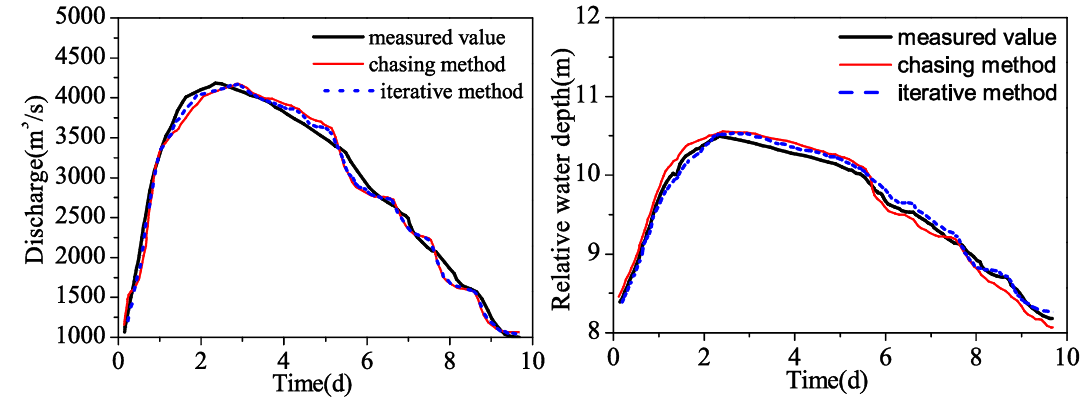
Fig. 10 Verification of the calculated flow rate and water level in Shoubayan